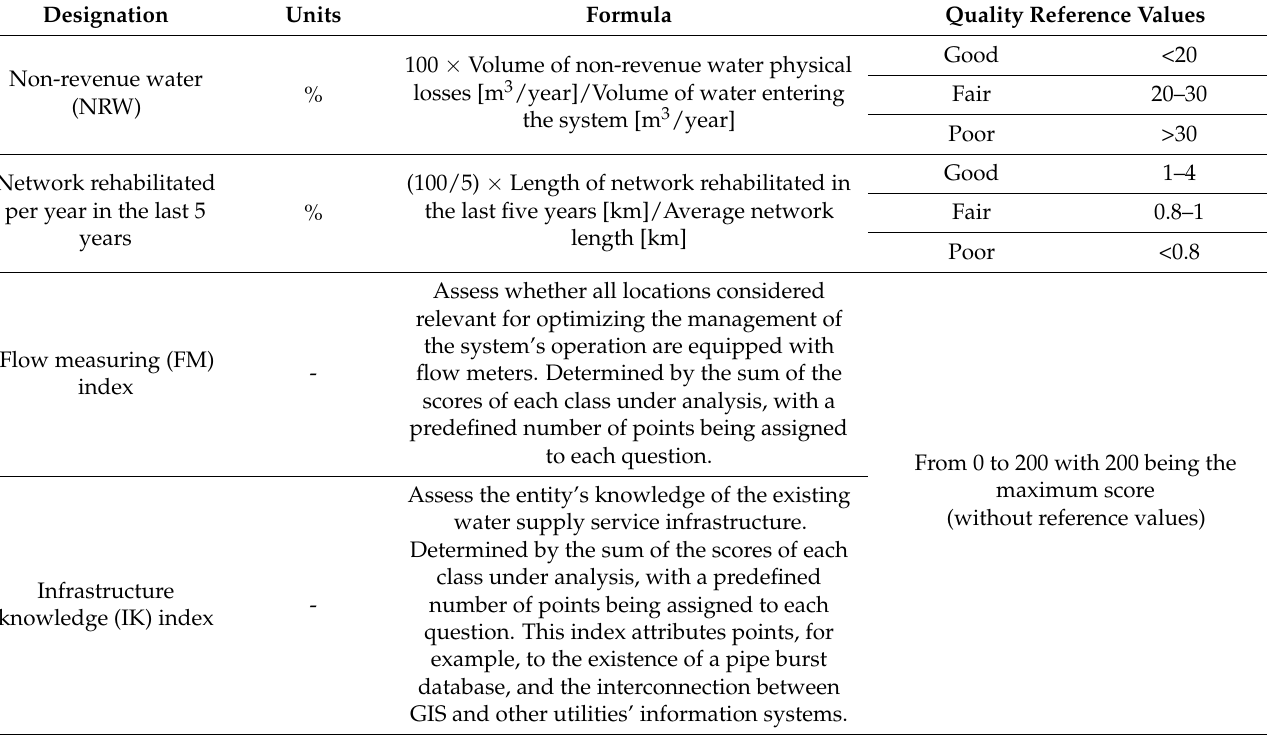
Table 1. Indicators used to evaluate the performances of water utilities. More information can be found in ERSAR’s latest version of the quality evaluation guidelines